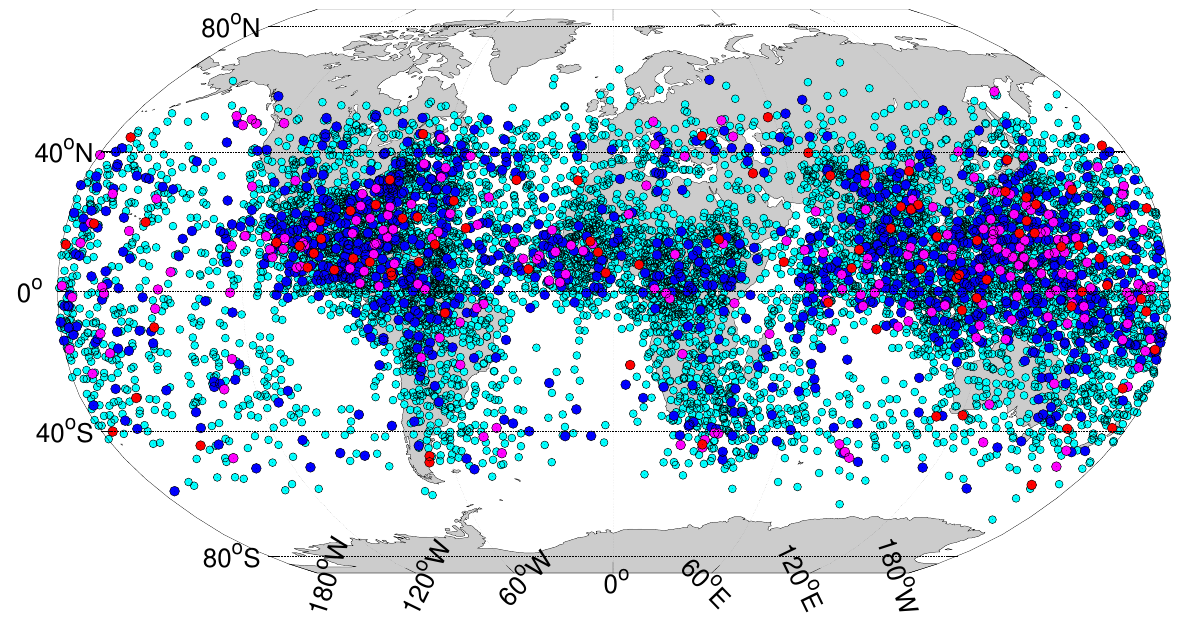
Figure 18. Geographical distribution of slow flashes. Colors denote different ranges of amplitudes the same way as in Figure 14 with the highest ones shown in red and the weakest in